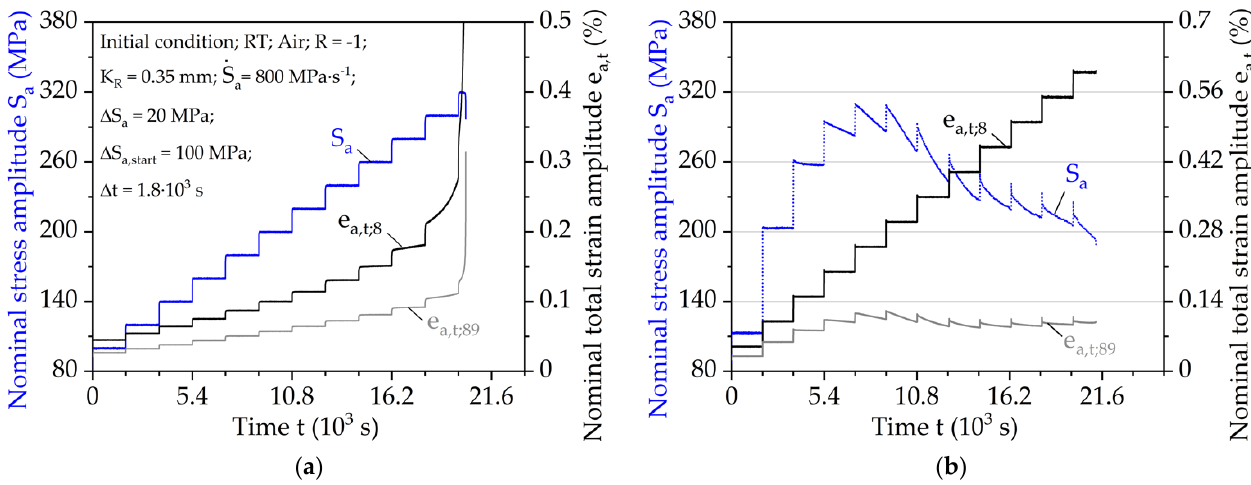
Figure 11. ( a ) Results of a nominal LIT at RT with 𝛥𝑆 𝑎 = 20 MPa and 𝑆 𝑎,𝑠𝑡𝑎𝑟𝑡 = 100 MPa and ( b ) Results of a nominal total strain increase test at RT with 𝛥𝑒 𝑎,𝑡 = 0.05% and 𝑒 𝑎,𝑡,𝑠𝑡𝑎𝑟𝑡 = 0.05%.